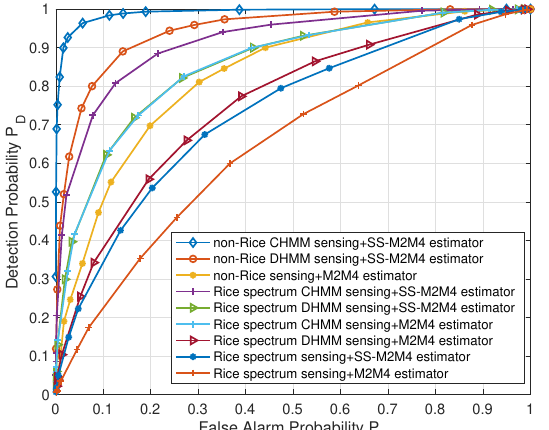
Figure 10. Detection probability versus false alarm probability under the Rice